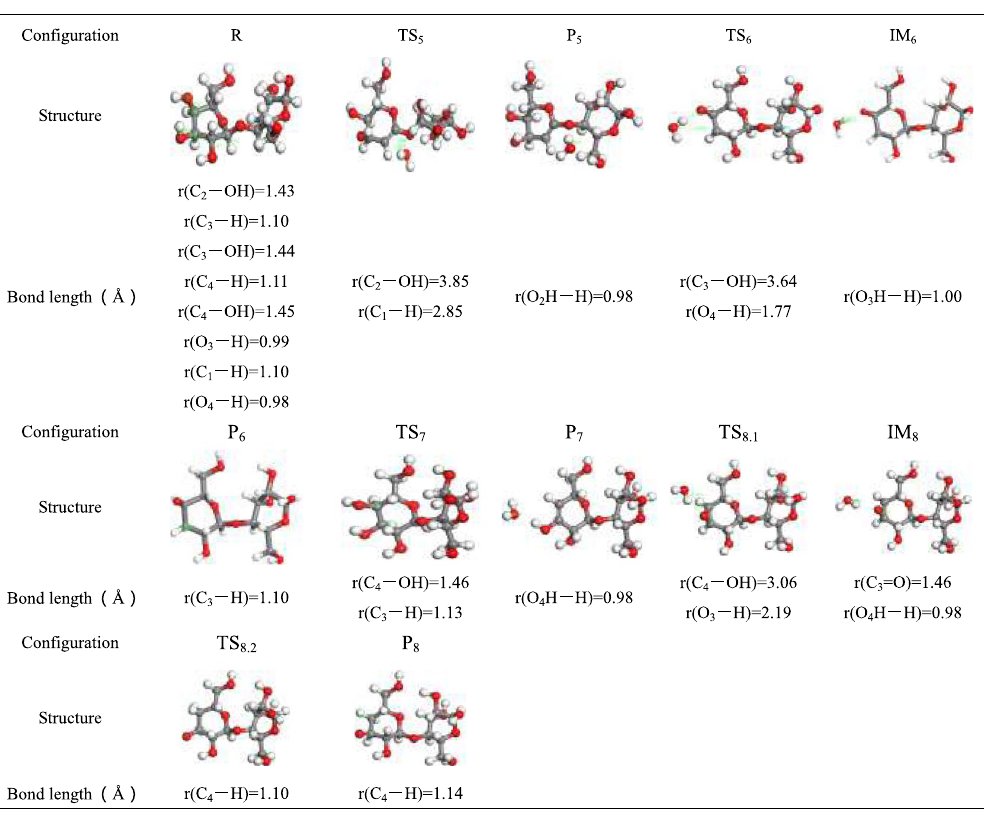
Table 6. Optimized configuration in pathway